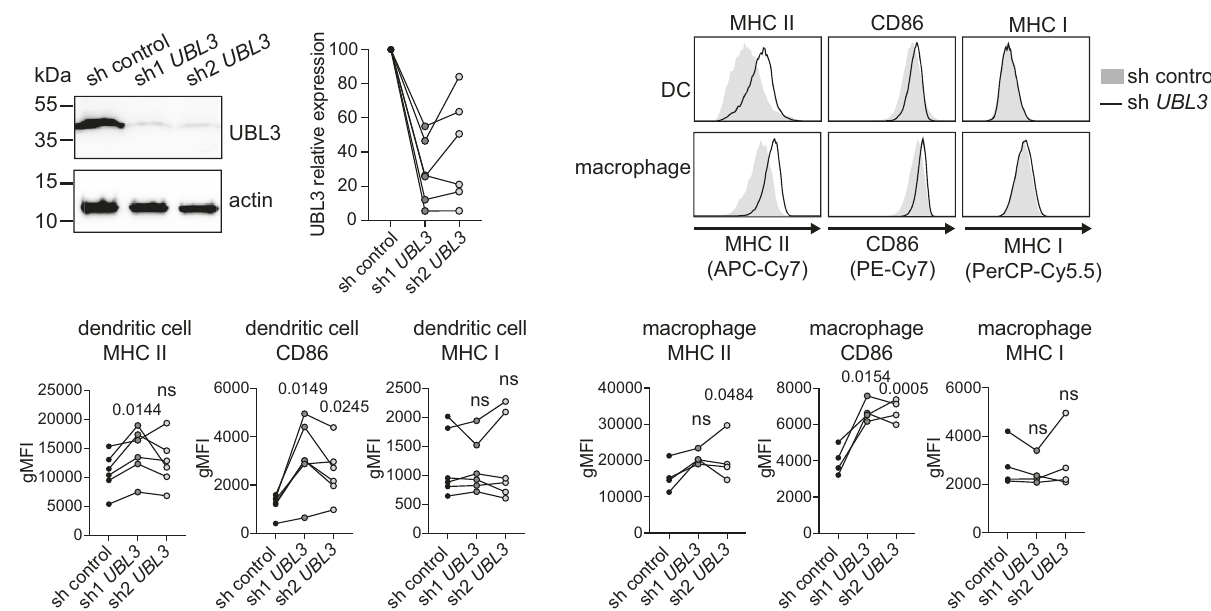
Fig. 8 UBL3 function is conserved in humans. Human CD14 + monocytes were infected with non-targeting control shRNA or shRNA against UBL3 (sh1 UBL3 or sh2 UBL3 ) and analyzed after fi ve days in culture. Top left: Cell lysates were probed with antibodies against UBL3 (LS-C661402) and actin, and quanti fi cation of gene silencing was determined by UBL3 signal intensity. Immunoblot depicts a scenario of approximately 95% UBL3 knockdown. Data from n = 6 donor samples examined in a single experiment, with symbols connected with a line representing individual donors. Top right: Surface MHC II, CD86, and MHC I on monocyte-derived DCs (CD16 − CD1a + ) and monocyte-derived macrophages (CD16 + CD1a − ) were analyzed by fl ow cytometry. Histograms are representative of analysis from one donor. Bottom: Graphs showing data from n = 6 (DCs) or n = 4 (macrophages) donor samples examined in a single experiment, with symbols connected with a line representing individual donors, p values shown above points, ns not signi fi cant, repeated measures one-way